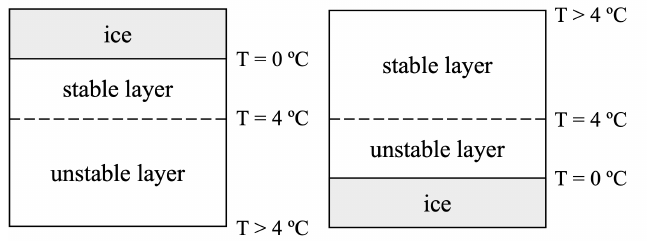
Figure 1. The diagrams show which regions of water will be stable or unstable depending on the temperature of the water and the location of the ice layer (top or